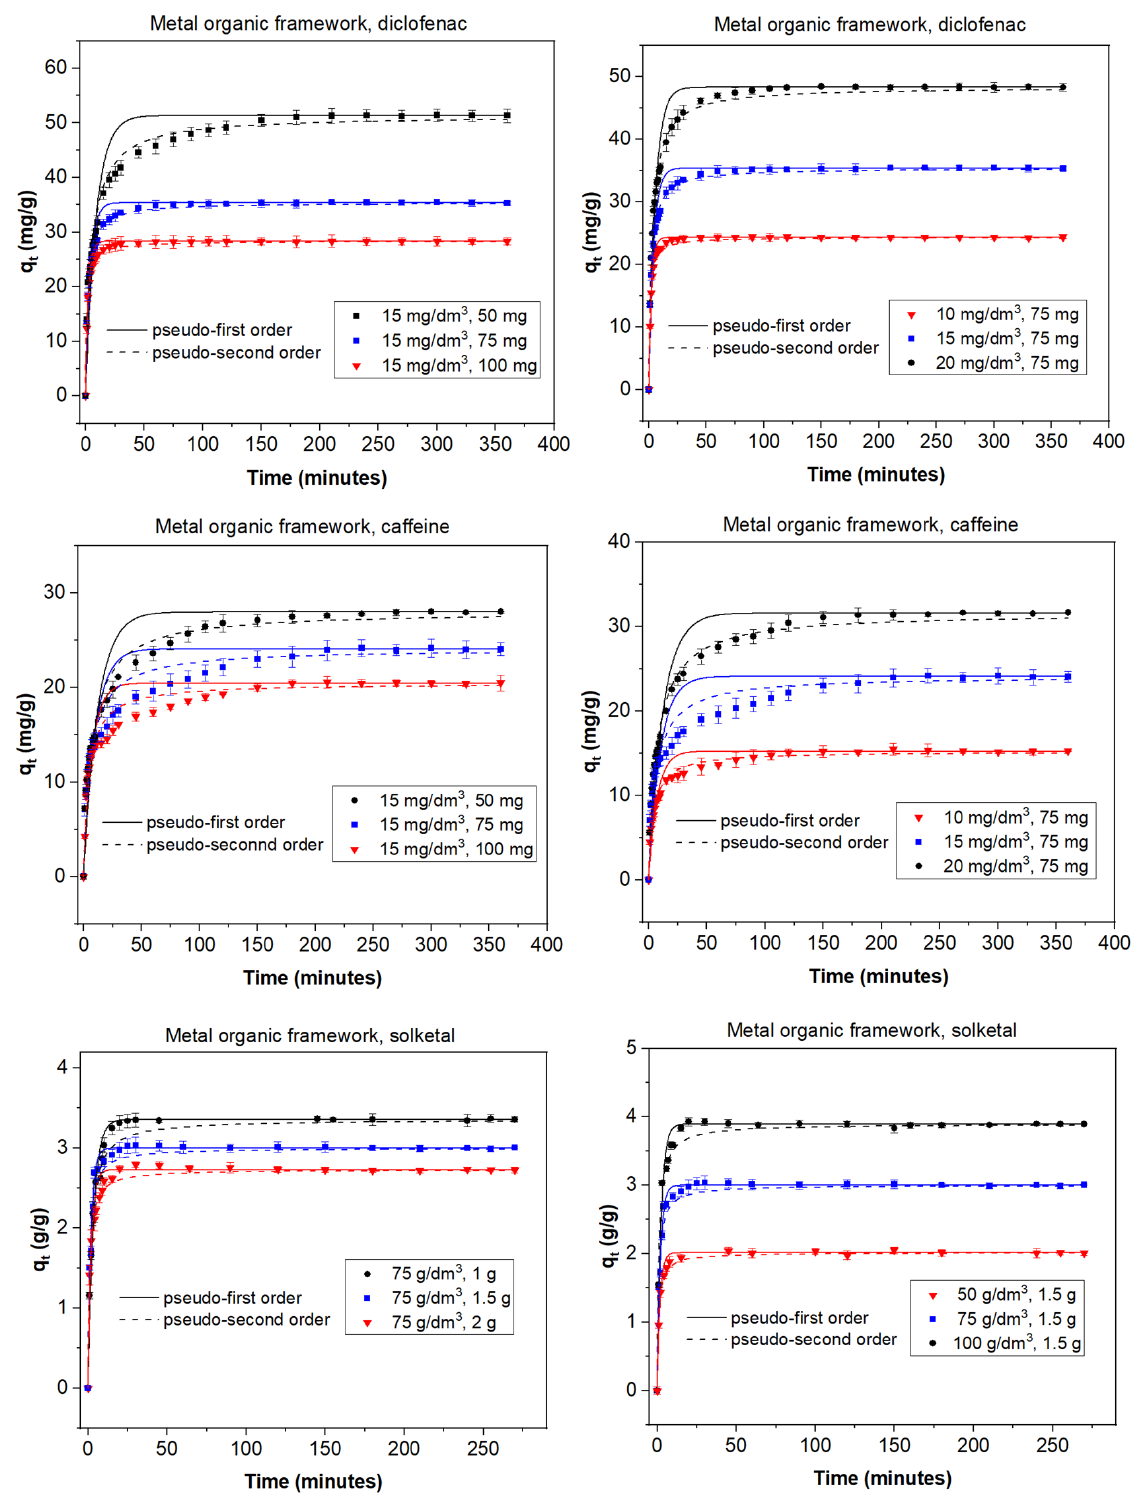
Figure 2. Kinetic adsorption data for diclofenac, caffeine, and solketal on the MOF using various adsorbate concentrations (10–20 mg/dm 3 ; 50–100 g/dm 3 ) and adsorbent amounts (10–30 mg; 1–2 g). T = 298 K.